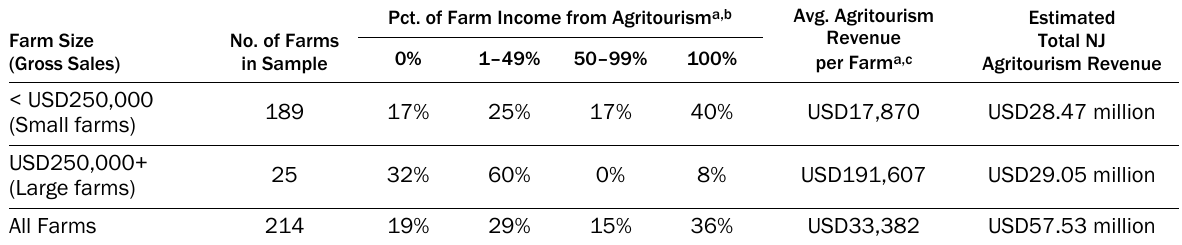
Table 5. Reliance on Agritourism as a Source of Farm Income, by Farm Sales Class, New Jersey Farm Size (Gross Sales)